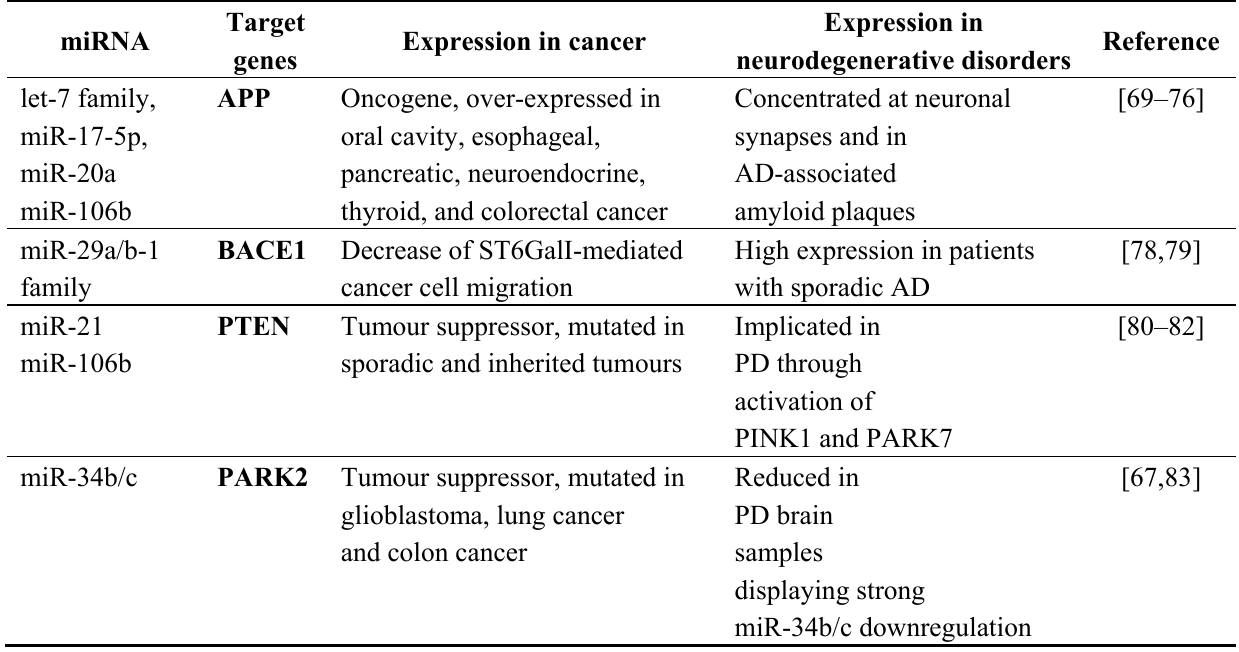
Table 4. Pathways regulated by multiple miRNAs (common to cancer and neurodegenerative diseases).